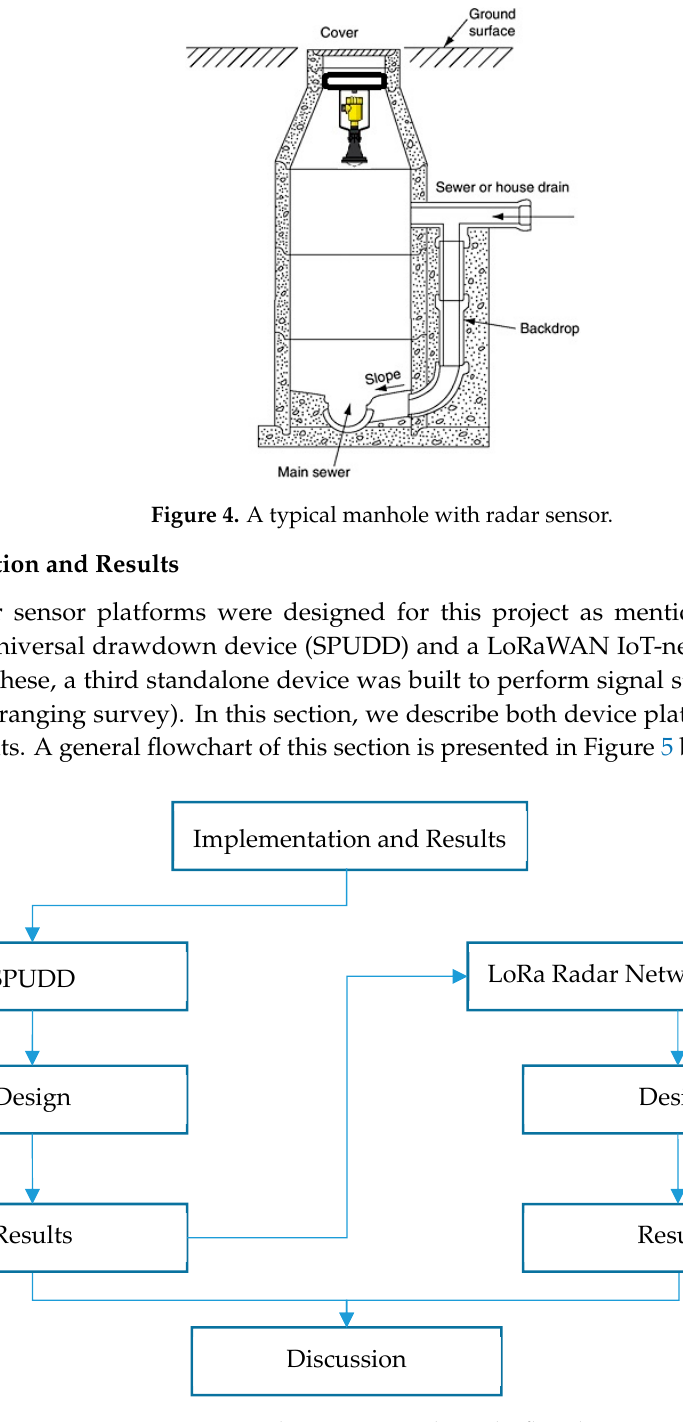
Figure 5. Implementation and Results flowchart.